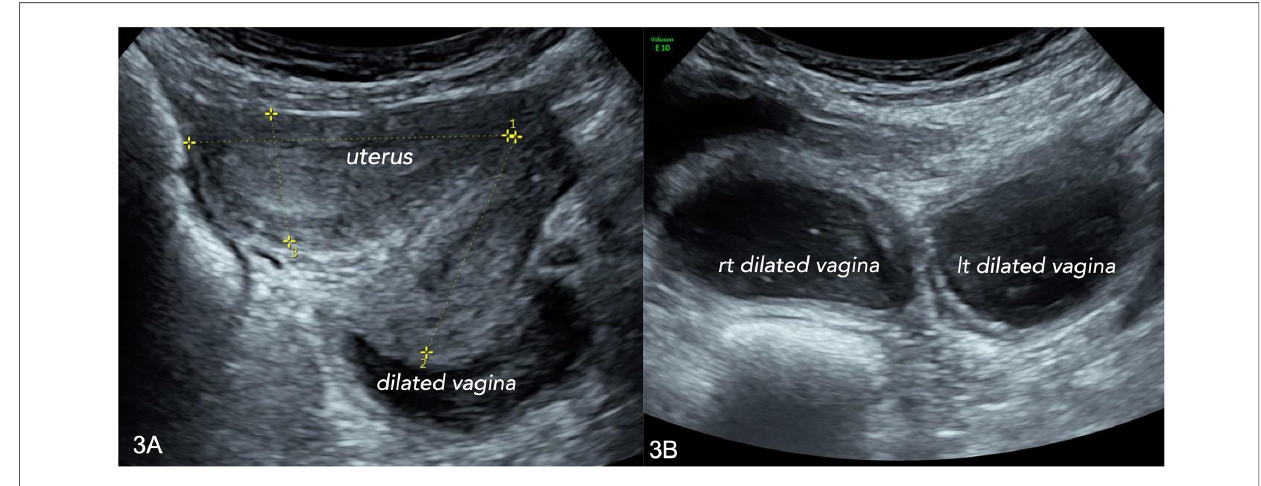
FIGURE 1 Transabdominal ultrasound. ( A ) right uterus and vagina, longitudinal scan; ( B ) both vaginas, dilated aspect, with “ low-level ” content, in in a transverse